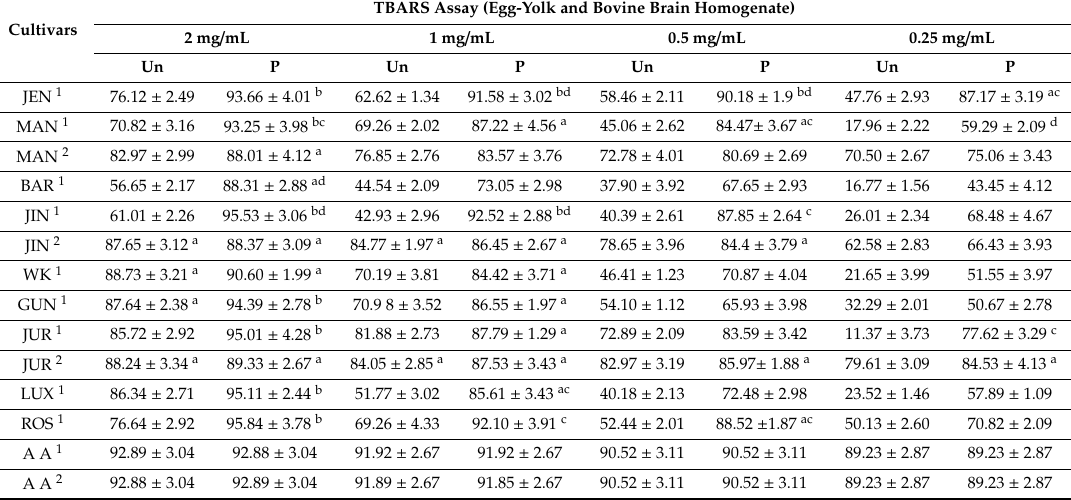
Table 4. Activity of lupin flour (processed and unprocessed) in LPO activity assayed by TBARS method using egg-yolk and bovine brain homogenate.